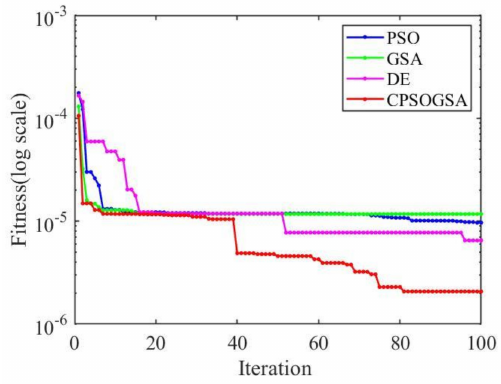
Figure 13. Convergence curve of controller optimization.